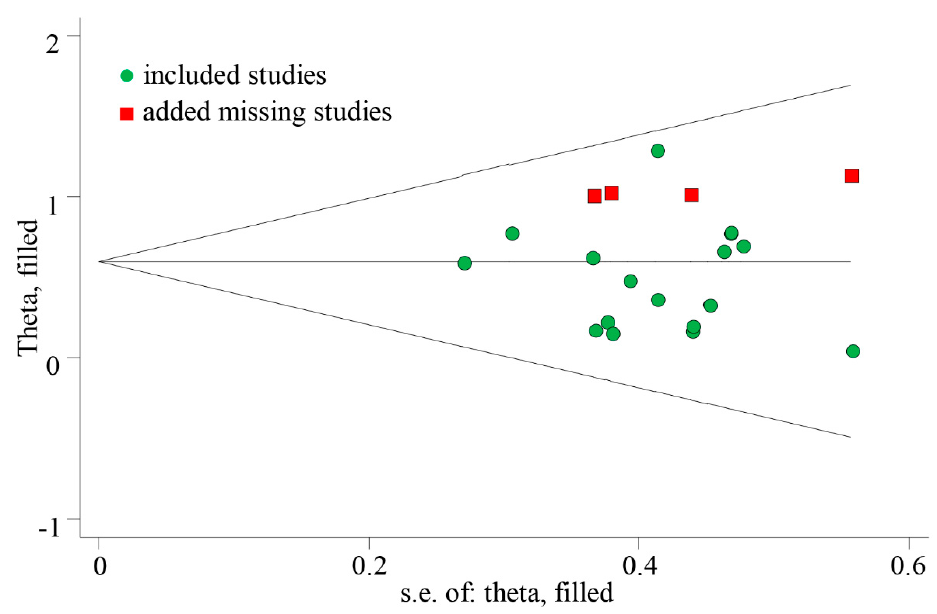
Figure 3. Funnel plot of standard difference in means versus standard error of 18 included studies.